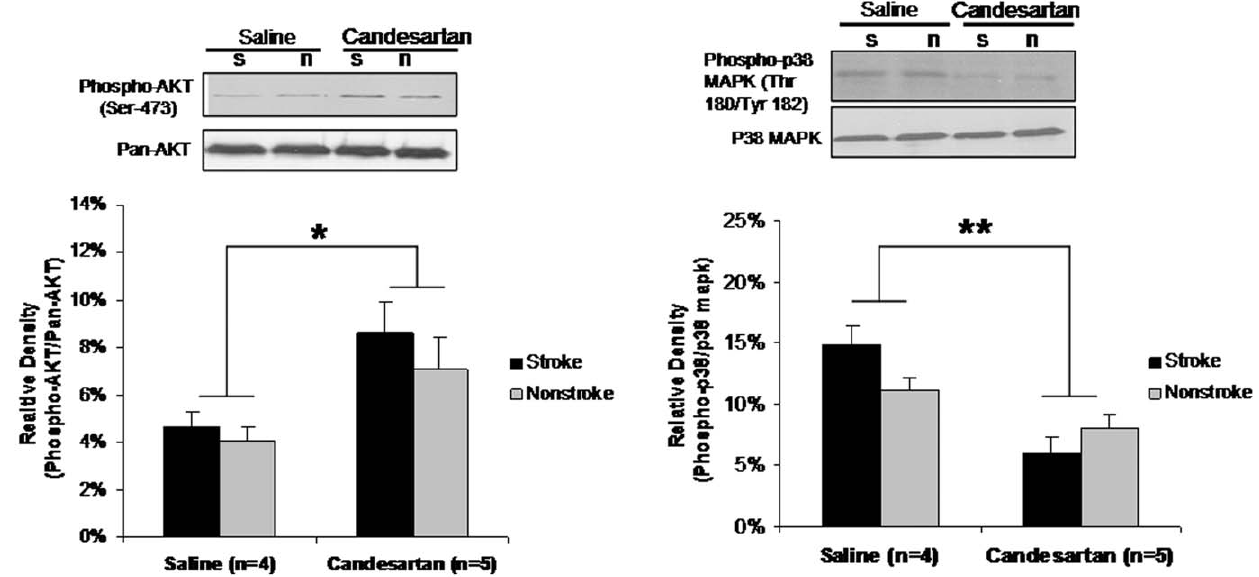
Figure 8. Akt and P38 pathway assay. Candesartan treatment significantly increased protein kinase B (AKT) activation (Figure 8a, *P , 0.05) and inhibited P-38 kinase activation (Figure 8b, **P , 0.01) in both hemispheres.